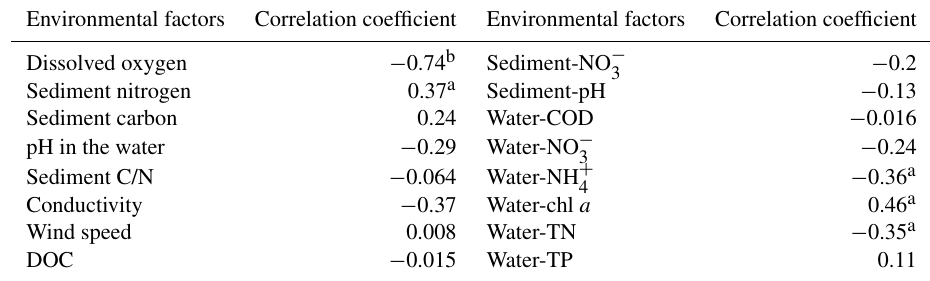
Table 2. Correlation relationship between seasonal CH 4 efflux and environmental factors.